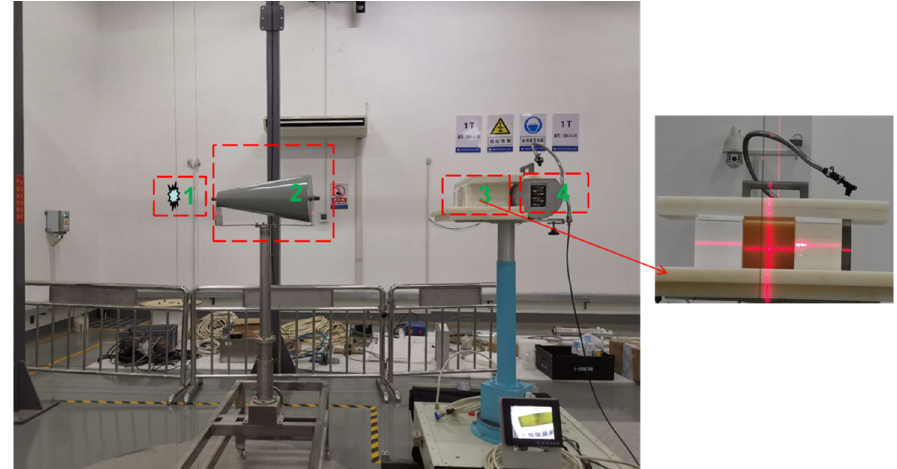
Figure 4. Layout of the neutron transmission experiment with a shadow cone and without polyeth- ylene moderation (1: neutron source: lifted from the basement when in use; 2: shadow cone: shields the direct neutrons; 3: polyethylene shielding layer; 4: neutron ambient dose equivalent (rate) meters).